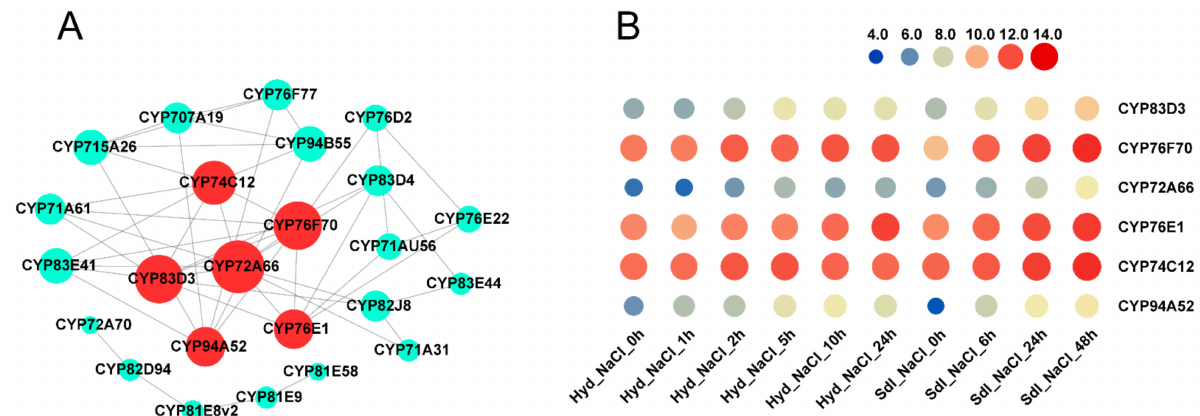
Figure 7. Co-expression network analysis and hierarchical clustering of expression profiles of MtP450 genes under NaCl stresses. Co-expression network analysis ( A ) and hierarchical clustering of expression profiles ( B ) of MtP450 genes under NaCl treatments from microarray